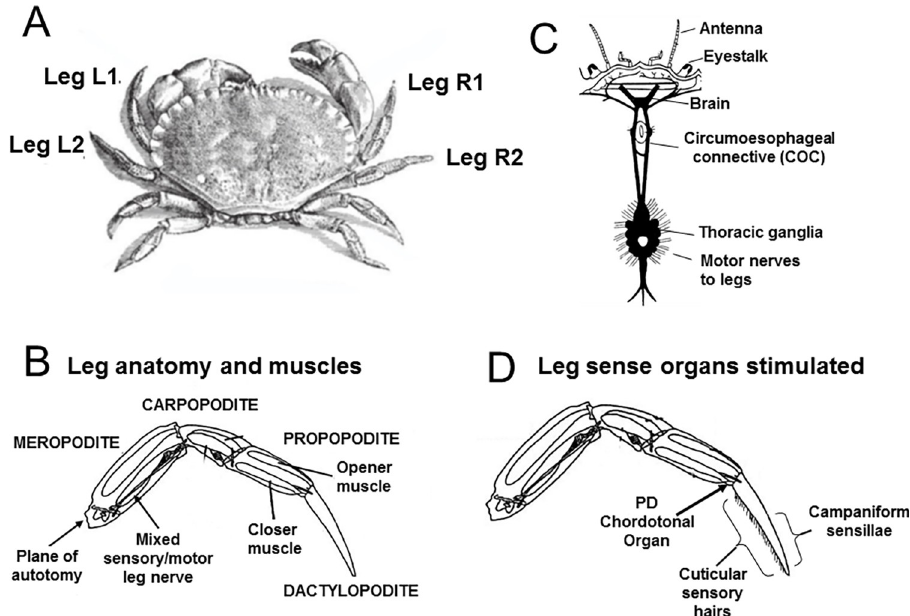
Fig 1. Schematic diagram of the anatomy of the crab Cancer pagurus L. A, External anatomy and numbering of legs. B, Arrangement of the nervous system. C, Leg anatomy and muscles. D, Leg sense organs stimulated in the current